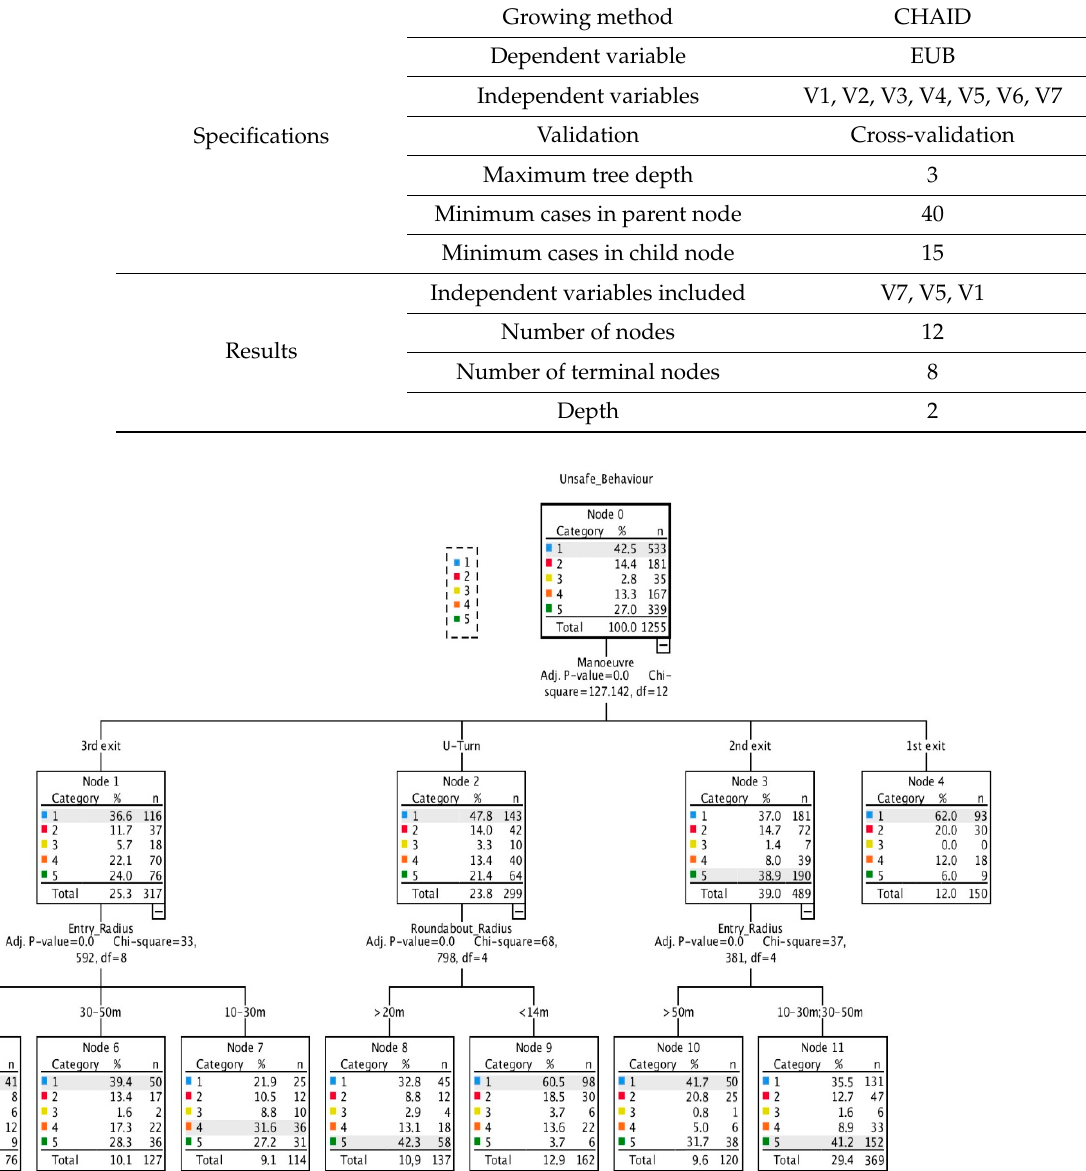
Figure 3. Tree diagram obtained from CHAID analysis for entry unsafe behaviors at double-lane roundabouts.